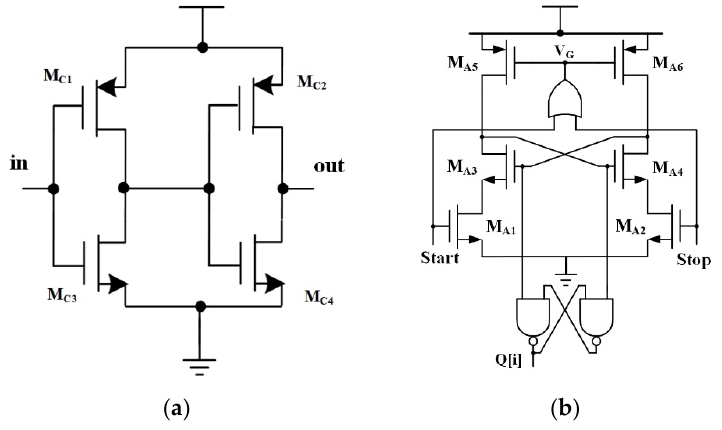
Figure 7. ( a ) Structure of the delay unit in the CTDC; ( b ) structure of the arbiter in the CTDC.